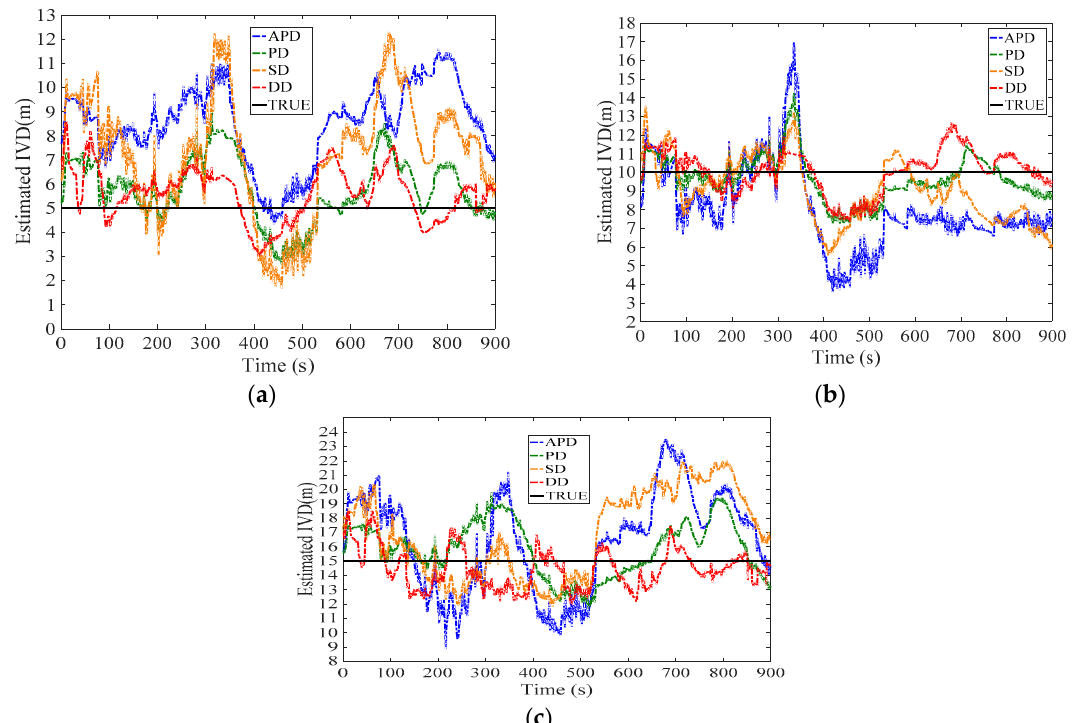
Figure 17 . Dynamic experiments with open sky scenario, (a ) Baseline = 5 m , ( b ) Baseline = 10 m, (c ) Baseline = 15 m Figure 17. Dynamic experiments with open sky scenario, ( a ) Baseline = 5 m, ( b ) Baseline = 10 m, ( c ) Baseline = 15 m.